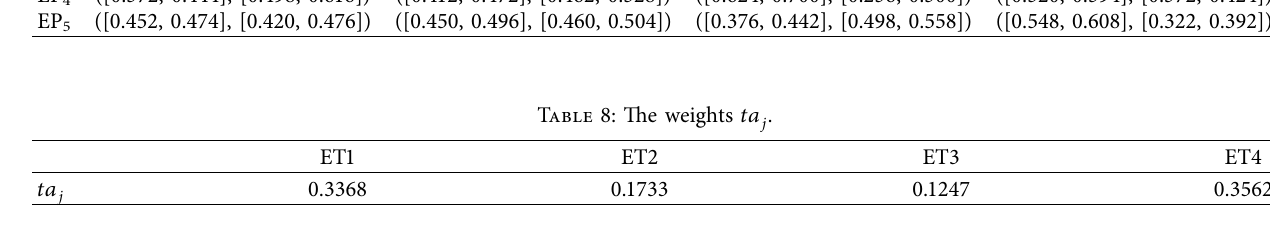
Table 9: GRC of each alternative from IVIFPIS.